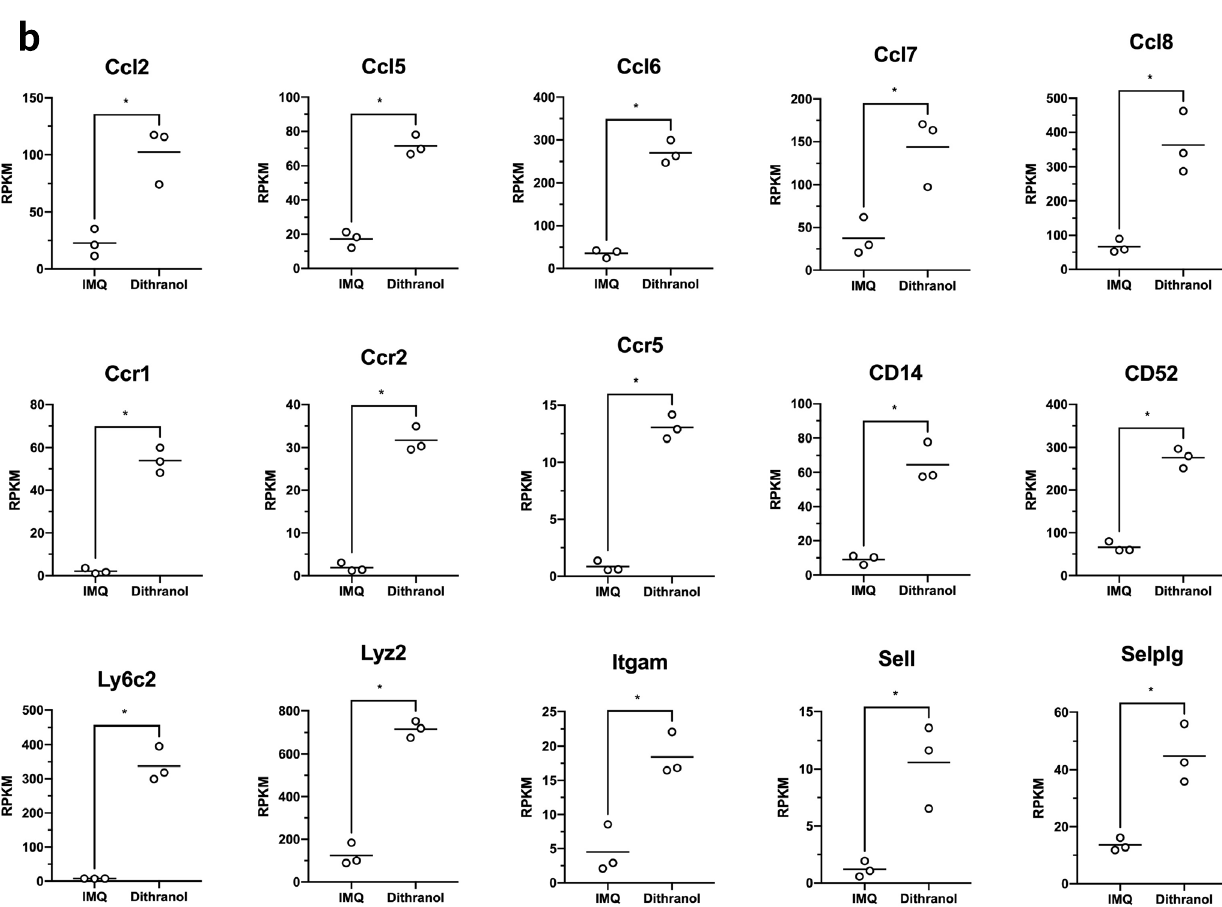
Fig. 5 RNA-seq of whole skin reveals dithranol, but not IMQ, as inducer of monocyte-speci fi c in fl ammatory gene signature. a Bulk RNA- seq-based heatmap of differentially expressed (DE) genes (adjusted p value < 0.01 and log2FC ≥ 2) between IMI-Sol (IMQ) or dithranol-treated wildtype mice ( n = 3) from murine ear skin cells. Monocyte related genes are highlighted in the blow-up section. The differential expression intensity is colored for each row from min (blue) to max (red). b Box plots with expression values of monocytic genes are shown for each of the genes, that are highlighted in a . In b , * p < 0.05 was evaluated by two-tailed unpaired T test followed by Welch´s correction. The complete data set of this experiment is available under GEO accession number